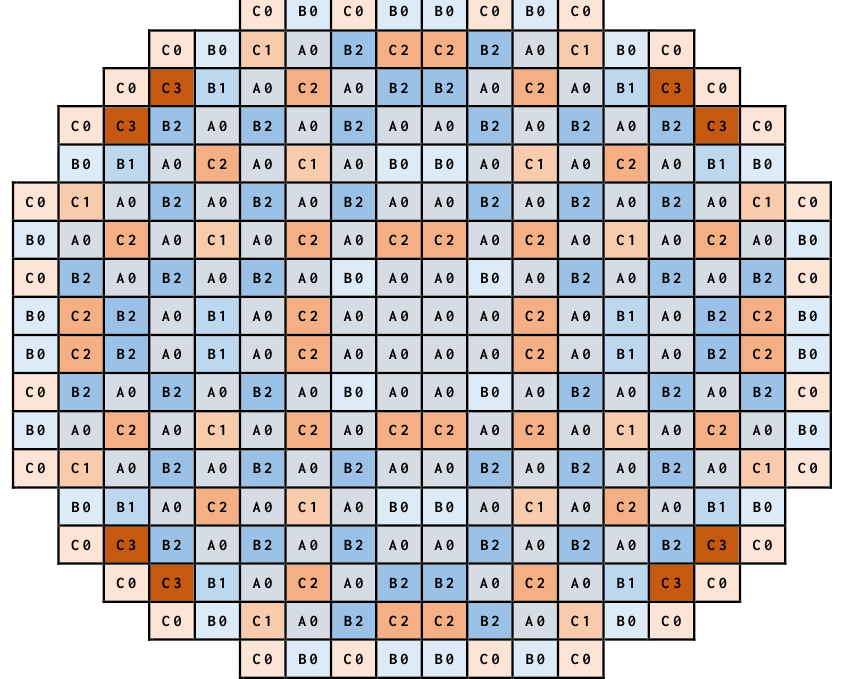
Figure 2. Fuel loading pattern.